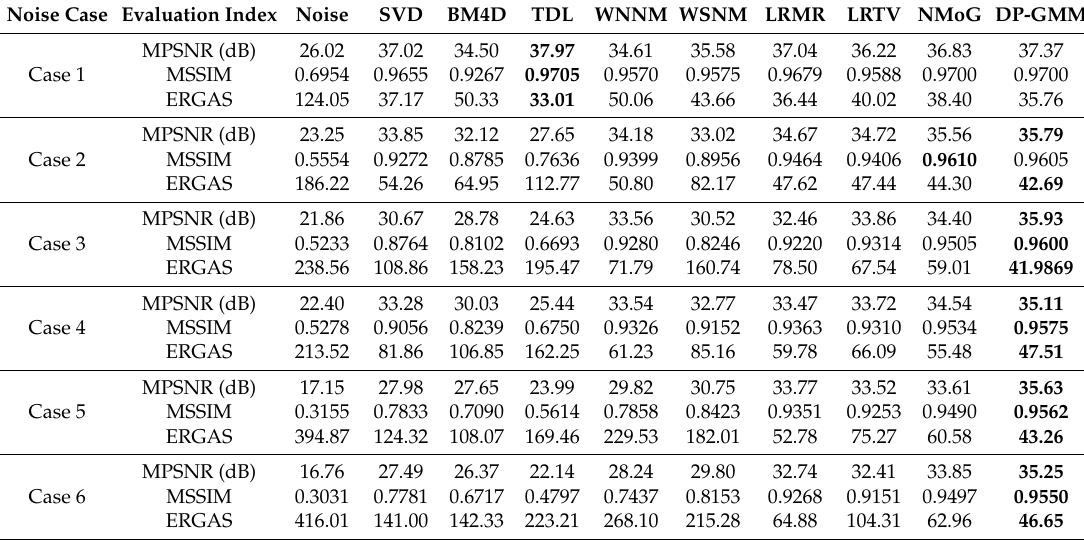
Table 2. Quantitative Evaluation of different methods on the simulated RemoteImage dateset in different cases of